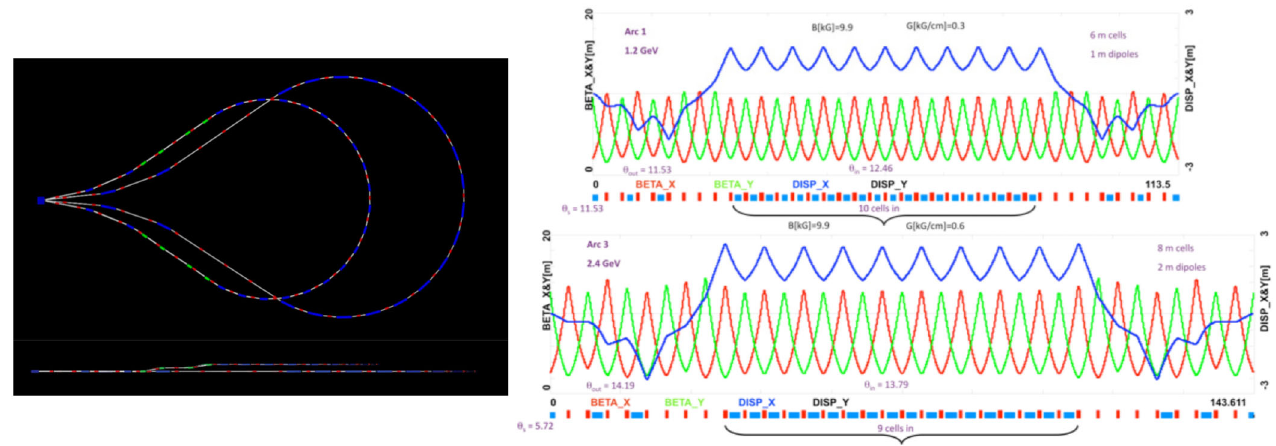
FIG. 11. Left: Layout of the recirculation arcs for 1.2 GeVand 2.4 GeVof the first RLA in two projections. Right: lattice details of the arcs in OptiM.